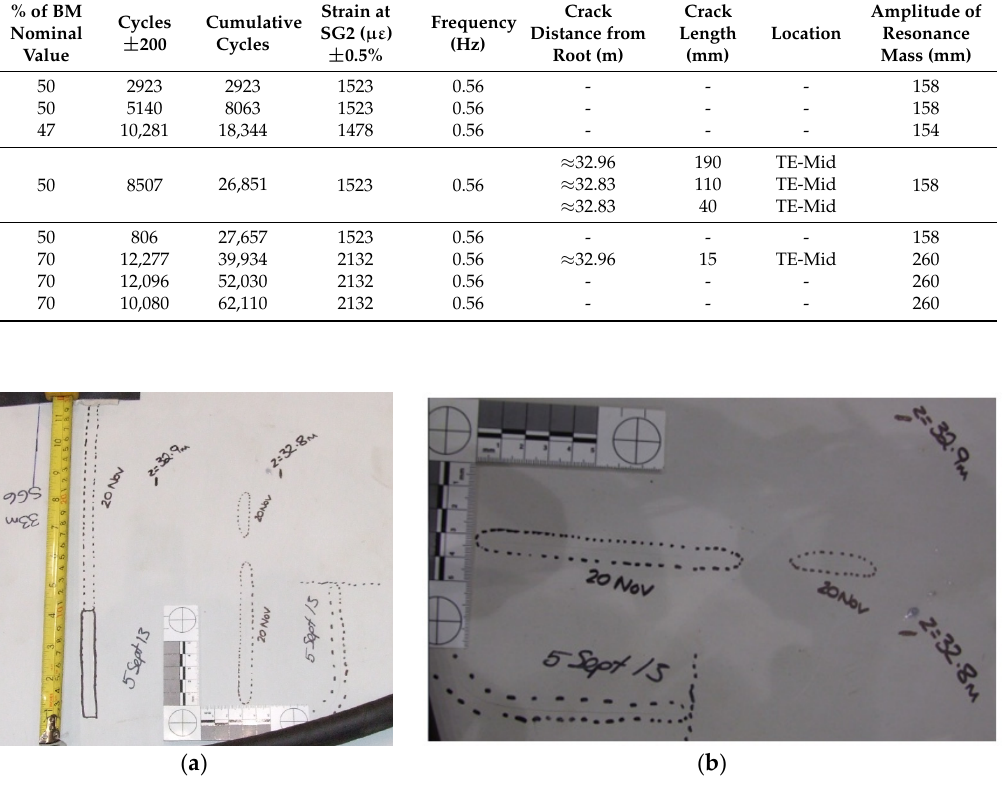
Figure 13. ( a ) Propagation of existing crack at 32.96 m after 26,851 cyclic loading; ( b ) Formation of hair line cracks at 32.8 m after 26,851 cyclic